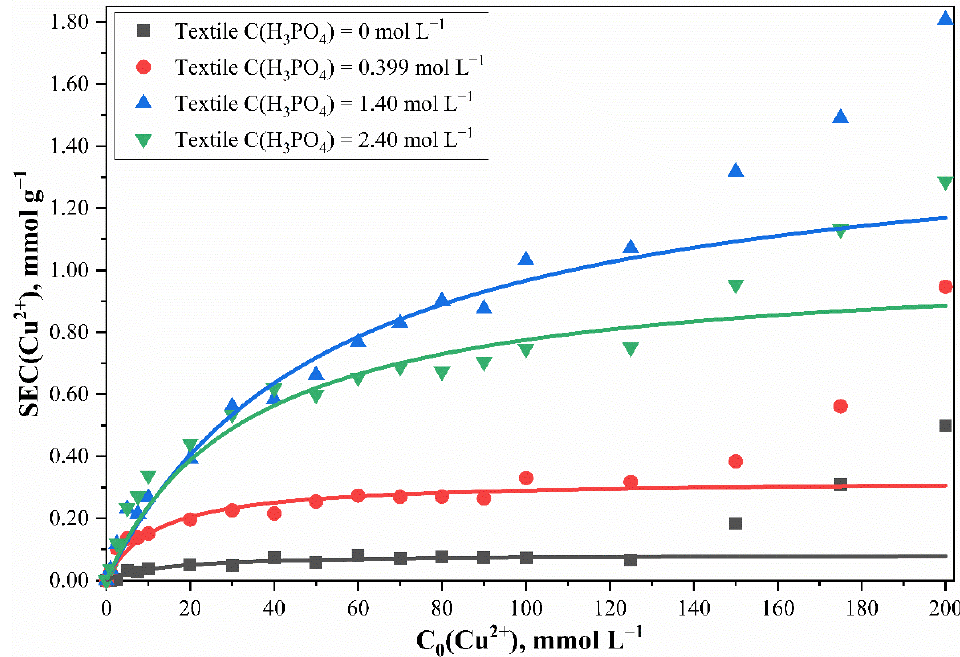
Figure 4. Cu 2+ sorption isotherms of cotton cellulose samples phosphorylated with phosphoric acid solutions of different concentrations. Points—experimental data; lines—calculated values according to the Langmuir equation. The temperature of the solutions during sorption experiments was t = 20 °C.